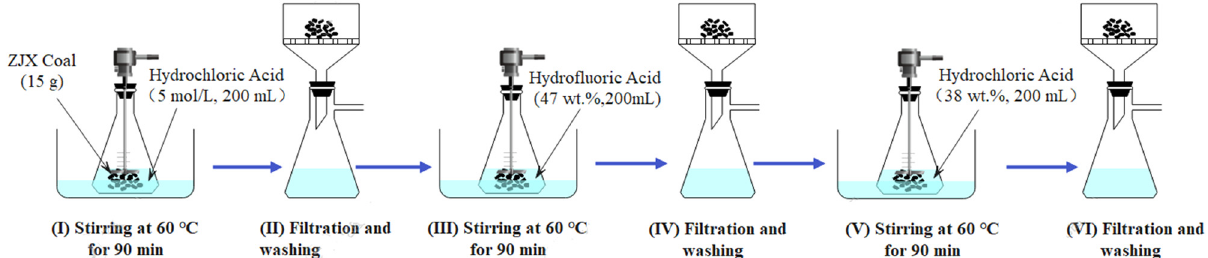
Figure A1: Detailed procedure of acid deashing process.